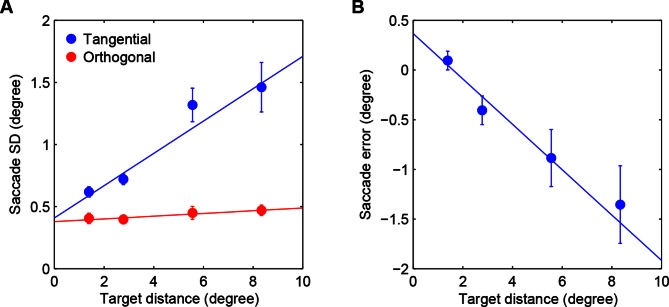
Saccadic variability and bias.(A) Saccadic standard deviation both along (tangential) and orthogonal to the target direction with linear regression giving SD = 0:13×distance+0:41° and 0:011 distance+0:38°, respectively. (B) Saccadic bias along the target direction (negative is undershoot) with linear regression giving bias = 0:23×distance+0:37°. Error bars are SEM across participants.